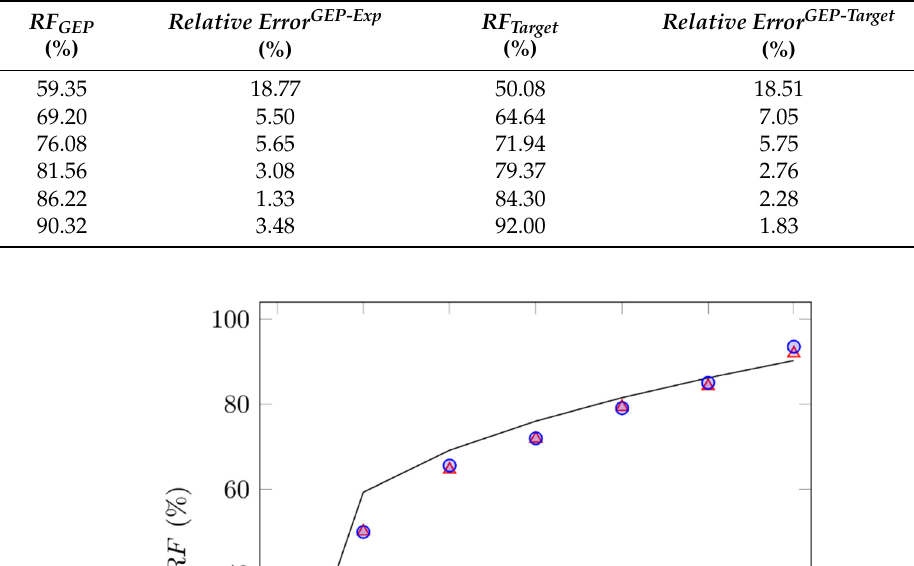
Table 9. Comparison of RF and relative errors of WAG injection generated by the developed correlation, mathematical model, and experimental work.